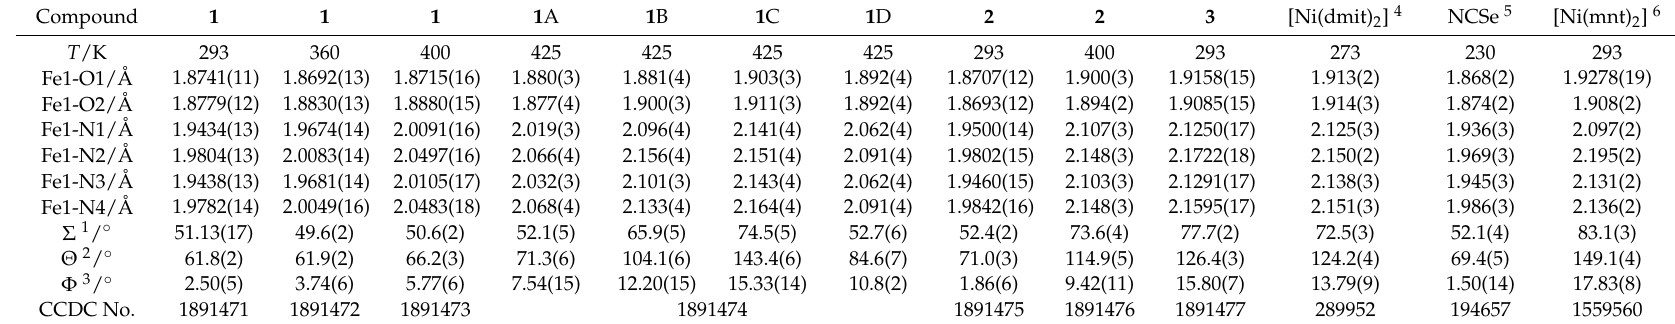
Table 5. Coordination bond lengths and distortion parameters for 1 , 2 , 3 , and related